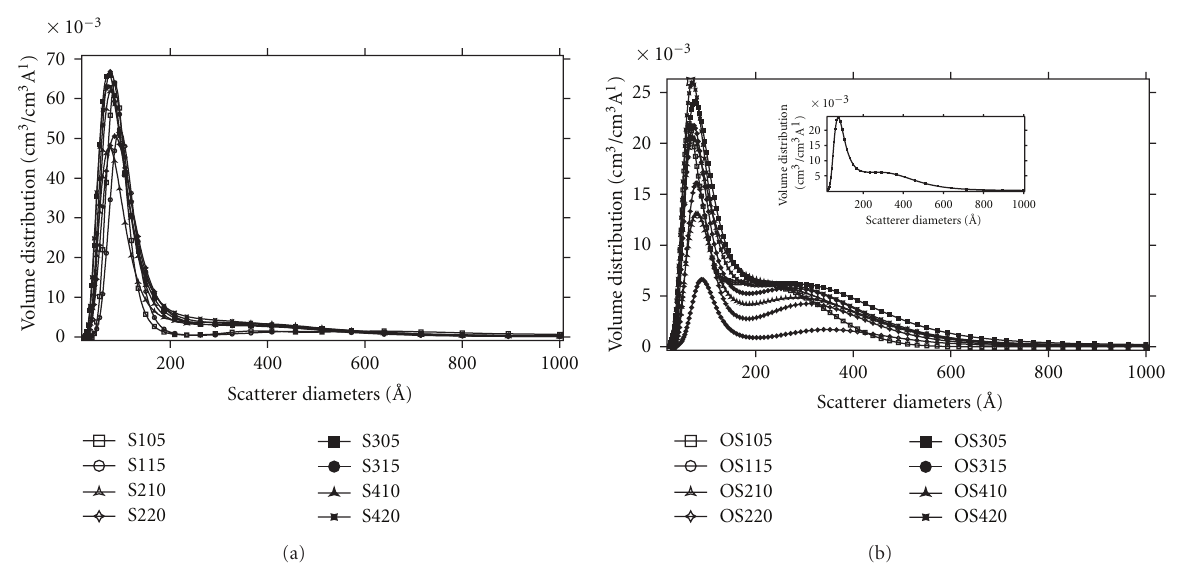
Figure 5: Size distribution calculation result via MEM method for starch/sorbitol/nanoclay nanocomposites (a) high-moisture-content samples and (b) low-moisture-content